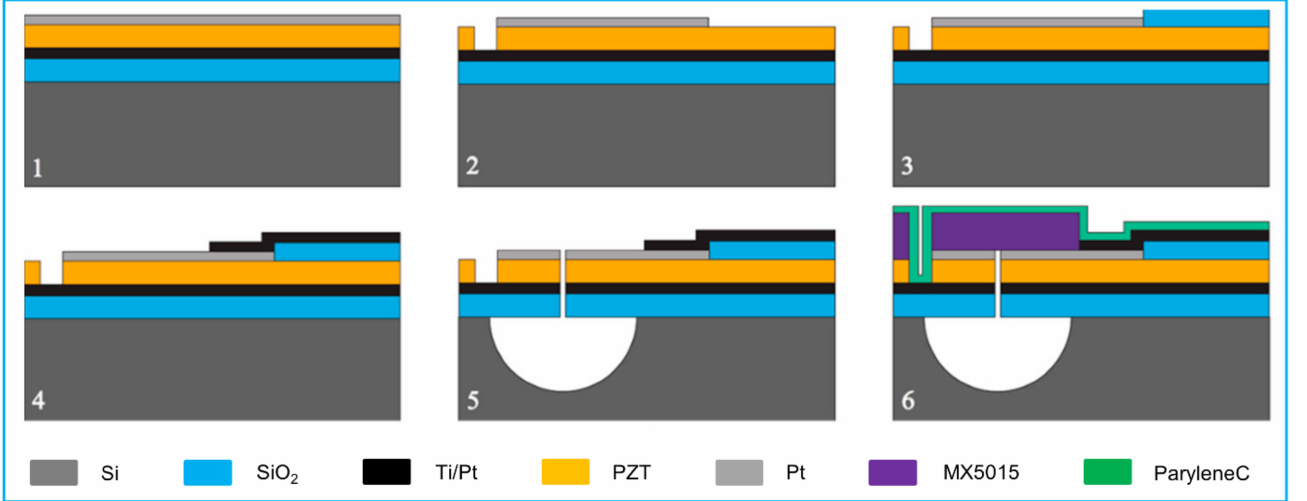
Figure 3. A typical fabrication processes of PMUT by the frontside etching method. Reprinted from Ref. [20] with permission.